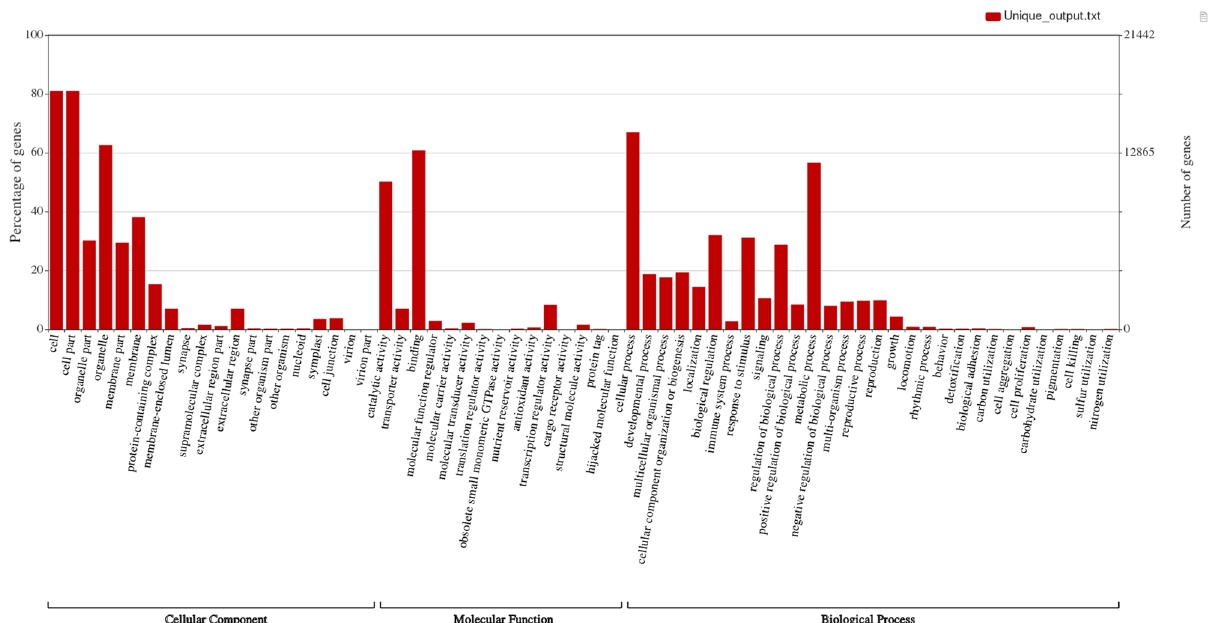
Figure 1. GO ontology annotation of cashew genome showing the major GO terms in each of the three categories of Molecular Function, Biological Process and Cellular Component. The left-hand Y-axis indicates the percentage of genes in a specific sub-category of each main category. The right-hand Y-axis represents the number of genes in a sub-category. Proportions were calculated using only the values of the major GO terms in each